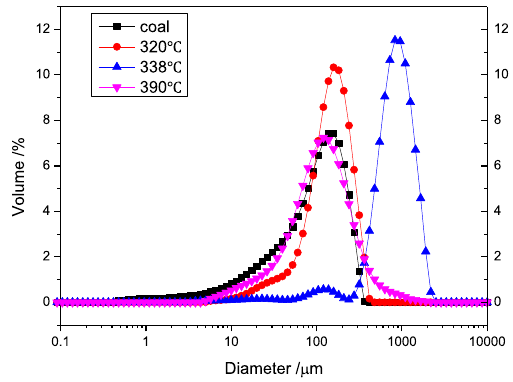
Fig. 7 Particle size integral distribution of coal particles under different conditions Table 5. It can be seen that the yields of asphaltene and preasphaltene do not show a maximum at 338 (cid:3) C.